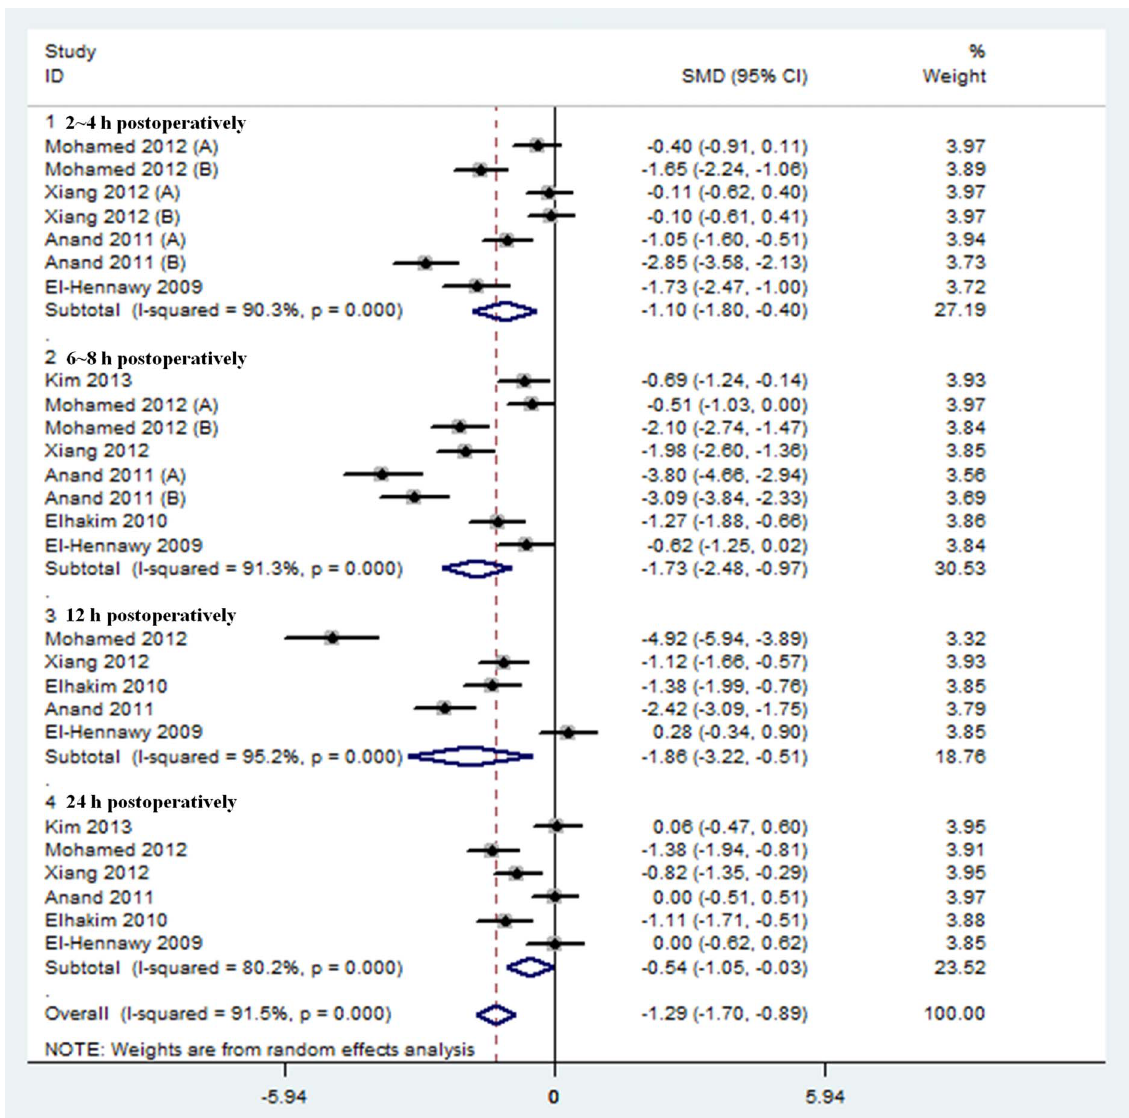
Figure 2. Forest plot: Postoperative pain intensity within 24 hours.